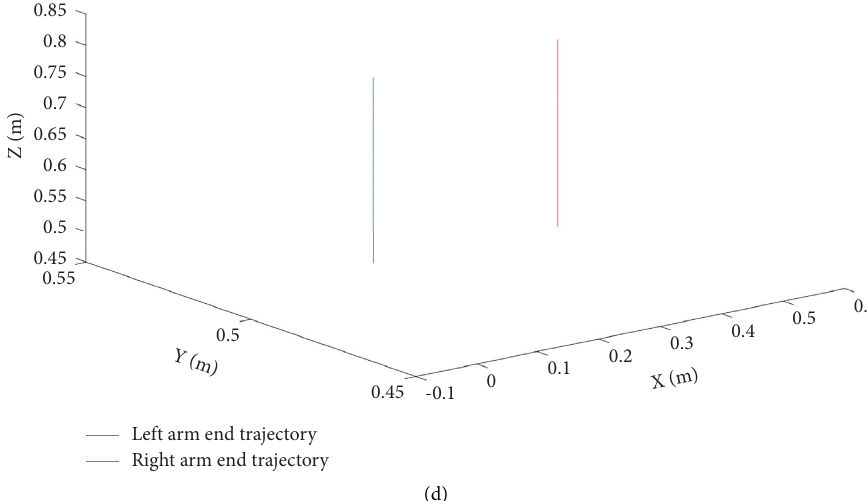
Figure 7: Coordinated trajectory of the dual arm. (a) Dual-arm joint angles. (b) Angular velocity of the dual-arm joints. (c) Angular acceleration of the dual-arm joints. (d) End-effector trajectory of the dual